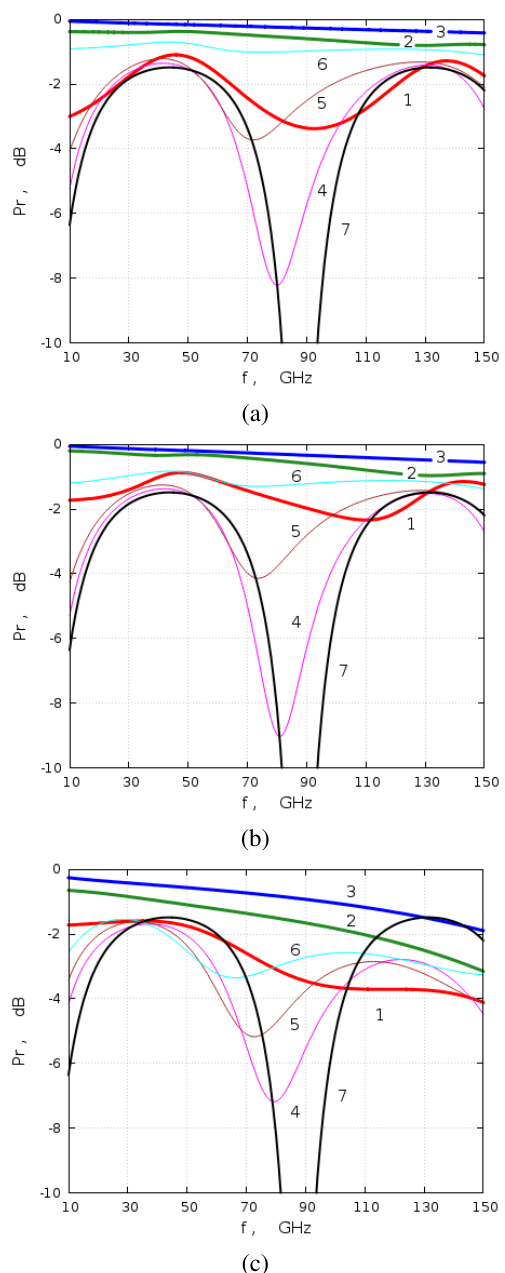
Figure 2: Transmission through (a) strip-like, (b) wire-like, and (c) fin-like photo-excited gratings for MM waves of E (curves 1 to 3) and H (curves 4 to 6) polarization at (a) P L = 0 . 1 , 1 , 10 kW/cm 2 , (b) P L = 1 , 10 , 100 kW/cm 2 , and (c) P L = 0 . 1 , 0 . 3 , 1 kW/cm 2 , respectively (curve 7 shows the dark-state results).